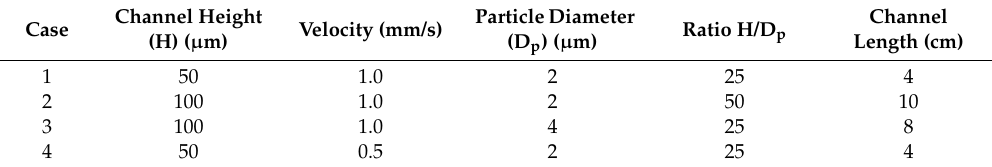
Table 4. Four different case studies to look at the influence of different parameters.